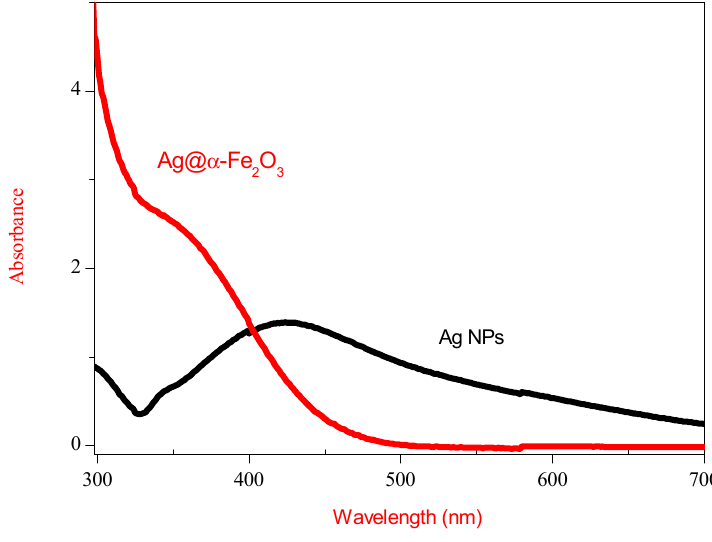
Figure 4. UV-Vis spectra of Ag nanoparticles and Ag@ α -Fe 2 O 3 core–shell nanocomposites. According to characterization results, formation mechanism for Ag@ α -Fe 2 O 3 core–shell